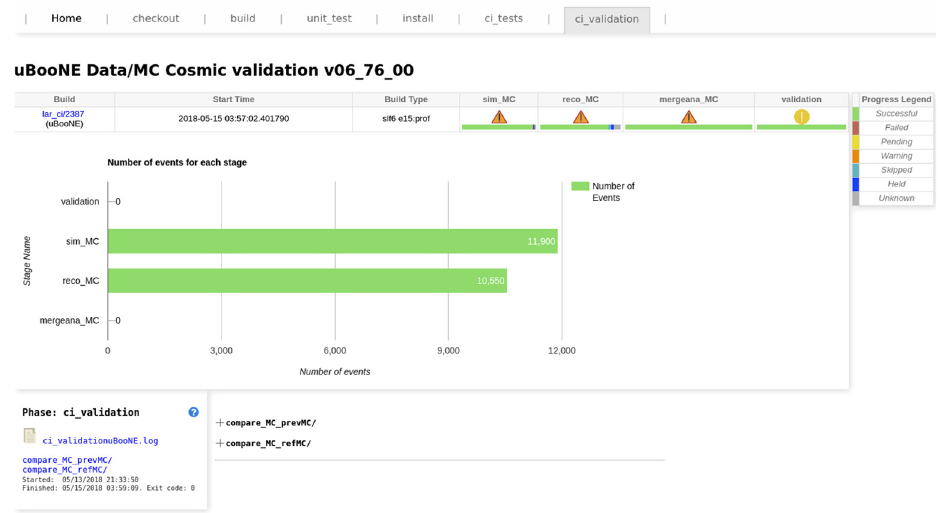
Figure 4. CI validation